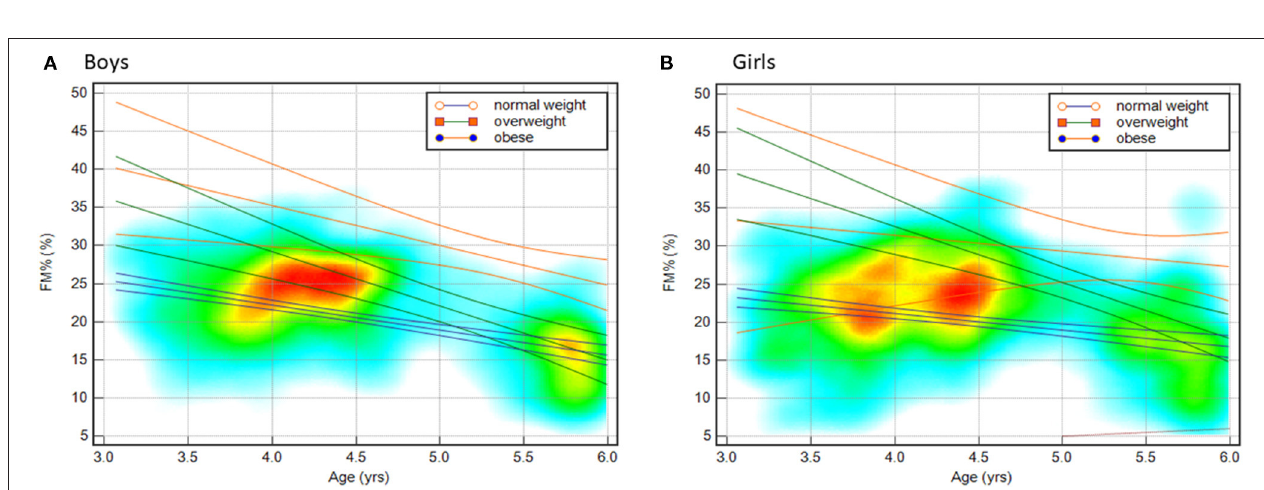
FIGURE 1 | [ (A) BMI; (B) FM%; (C) FMI; (D) FFMI; (E) .WHtR] Reference curves for BMI, FM%, FMI, FFMI, and WHtR of preschool children. Red area, mean – 2 SD of the mean – SD; yellow area, mean – SD of the mean; cyan area, mean to mean + SD; green area, mean + SD to mean + 2 SD. BMI, Body mass index; WHtR, Weight-to-height ratio; FM%, Percentage of fat mass; FMI, Fat mass index; FFMI, Fat-free mass index; SD, Standard deviation.